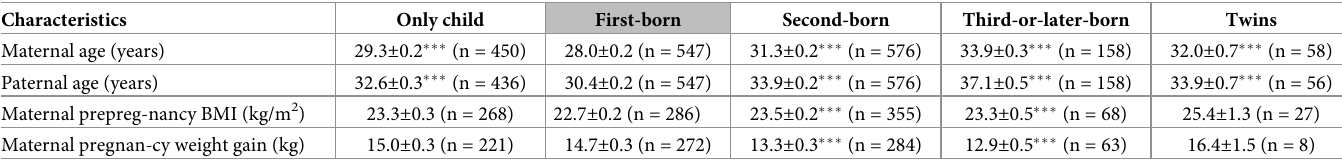
The table contains the parental characteristics stratified by sibling status. Values are means ± standard error of the mean. The numbers in parentheses correspond to the respective available number of cases. Significance was tested univariately with a mixed model, with first-born children as the reference group. Significant differences were marked with ��� p <